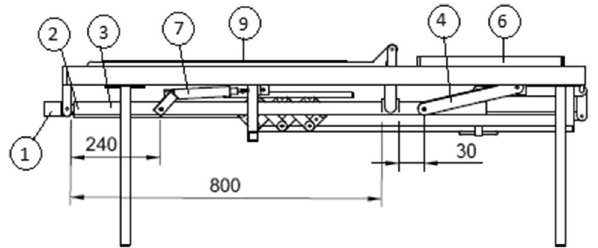
Fig. 4 New bed—sleeping position. (1: Screw, 2: Nut, 3: Sliding member, 4: Link, 6: Hip-rest, 7: Link, 9: Backrest)